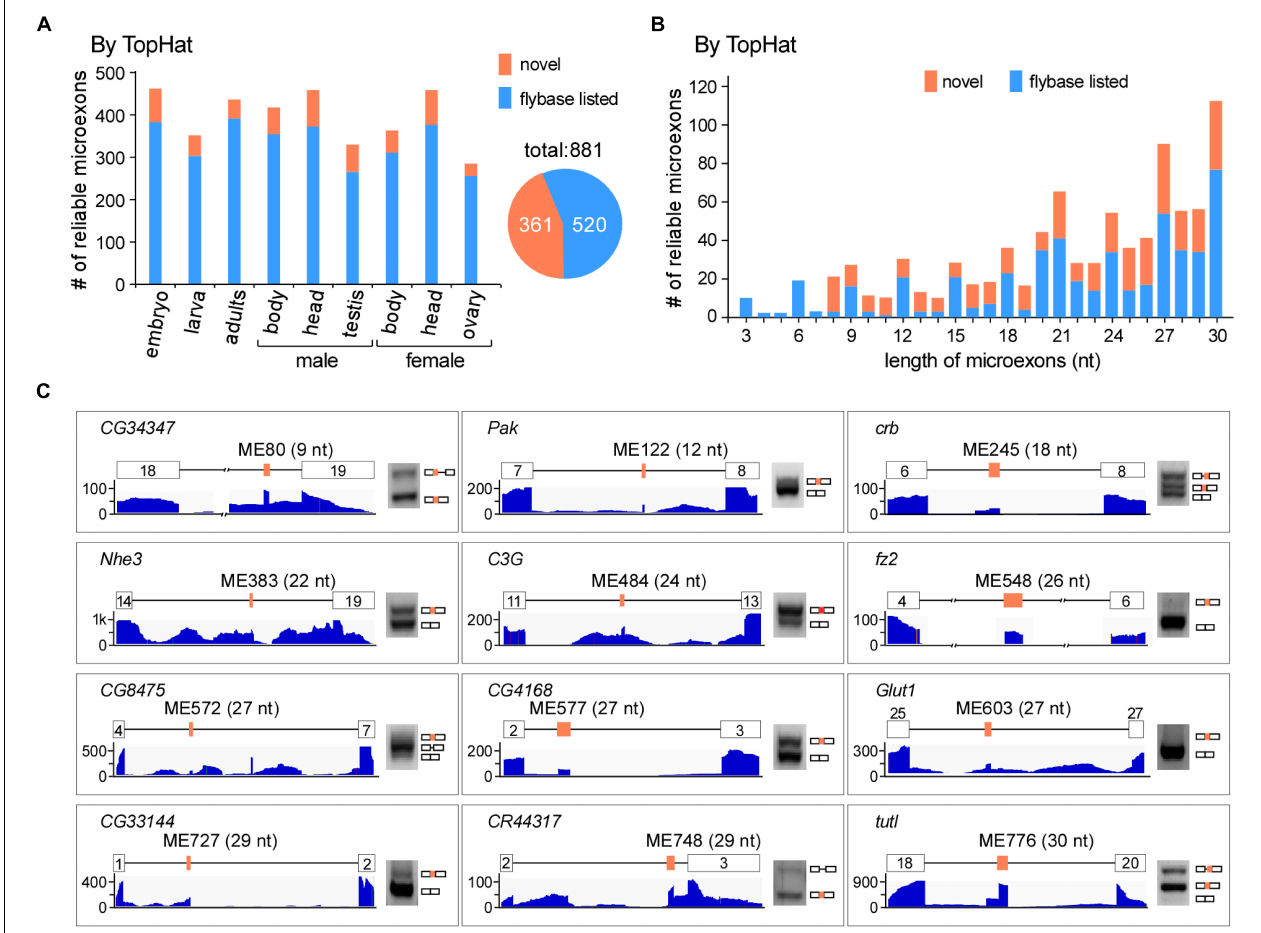
FIGURE 1 | Identification of microexons in Drosophila by TopHat. (A) Identified reliable microexons from RNA-seq data of a variety of Drosophila samples by TopHat. Orange: novel microexons; blue: annotated microexons in Flybase. (B) Length distribution of the identified microexons by TopHat. (C) Validation of novel microexons by RT-PCR. Each microexon was validated by amplification of cDNA using primers located in its flanking exons. Lengths and numbering of microexons and the genes to which they belong are indicated. Blank boxes: flanking exons, orange boxes: microexons. Primers information is listed in Supplementary Table 1